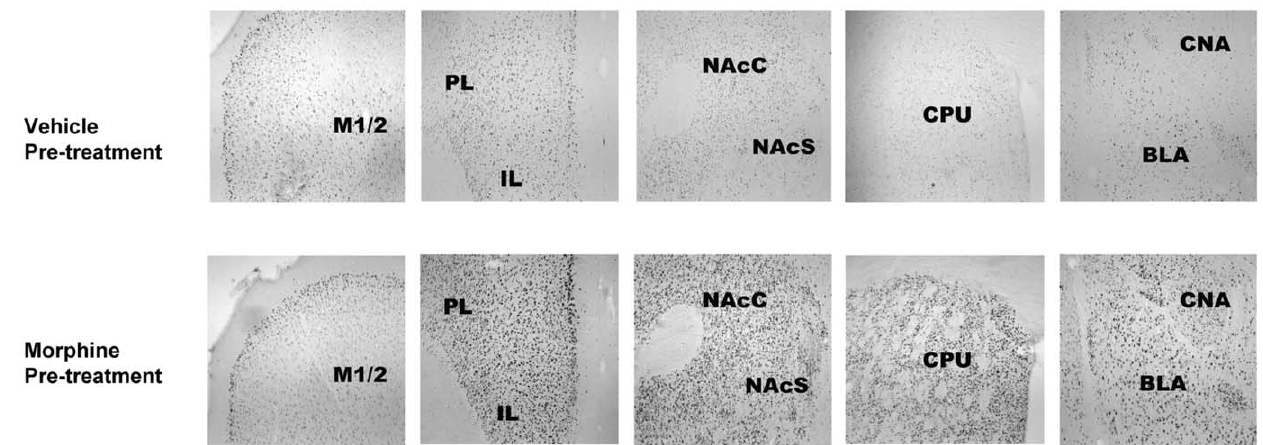
Figure 4. D FosB/FosB expression was determined by immunohistochemistry using anti-FosB/ D FosB polyclonal antibody in multiple sections. These representative photomicrographs (10-fold magnification) demonstrate FosB/ D FosB immunoreactive nuclei in PL, IL, M1/2, NAcC, NAcS, CPU, CNA and BLA brain regions. They were collected from vehicle and morphine pre-treatment treatment groups following vehicle injection and motor activity testing on day 16. The landmarks include: ACa, anterior commissure, and LV, lateral ventricle.